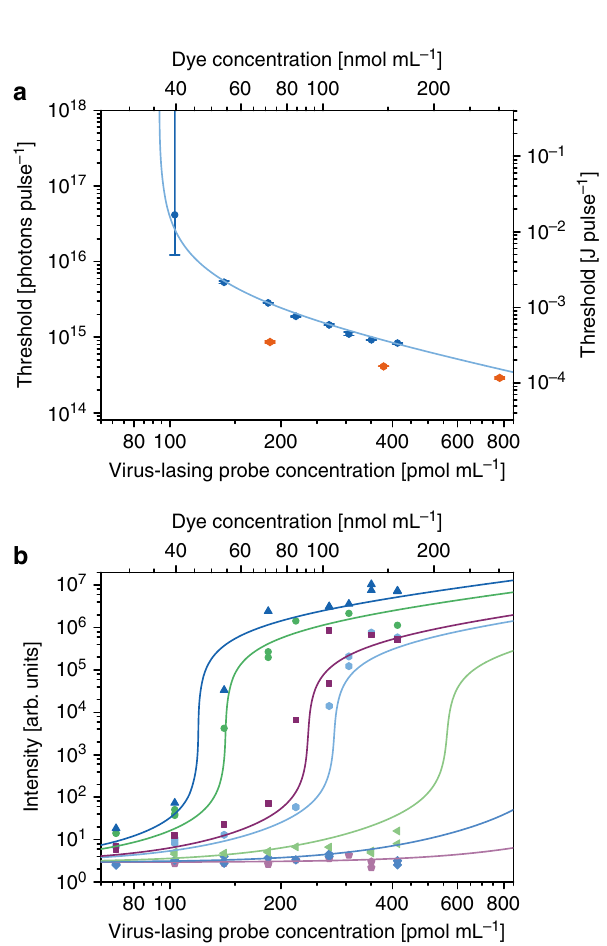
Fig. 3 Quanti fi cation of virus-lasing probes. a Response of the threshold point to variations in probe concentration. Scatter points represent the threshold point calculated by fi tting individual sets of threshold data of either V1 (dark blue) or fl uorescein (dark orange) using equation (26). The line is the expected dependence of the threshold point on the probe concentration calculated from the global fi t in Fig. 2a. The error bars are standard errors and the error bar that extends beyond the upper limit of the y-axis extends to in fi nity. b The intensity at different probe concentrations has been plotted at pump energies of 1.0 × 10 16 photons pulse − 1 ± 5.7% (dark blue), 5.4 × 10 15 photons pulse − 1 ± 7.6% (green), 1.8 × 10 15 photons pulse − 1 ± 6.2% (purple), 1.4 × 10 15 photons pulse − 1 ± 5.3% (cyan), 5.5 × 10 14 photons pulse − 1 ± 4.8% (light green), 2.5 × 10 14 photons pulse − 1 ± 6.3% (blue), 9.6 × 10 13 photons pulse − 1 ± 5.8 % (light purple). The lines are simulations from the same global fi t for the intensity against probe concentration at the same pump energies. Source data are provided as a Source Data fi